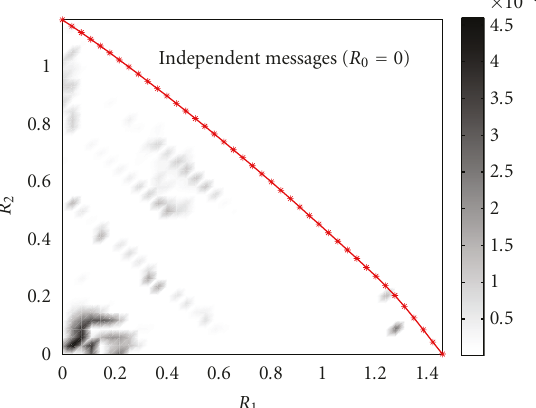
Figure 5: Di ff erence between the values of R 3 on the boundary of the capacity region for particular messaging ( R 0 = 0) and the values of R 3 generated by the proposed inner bound (for R 0 = 0). The boundary of the capacity region is marked by “ ∗